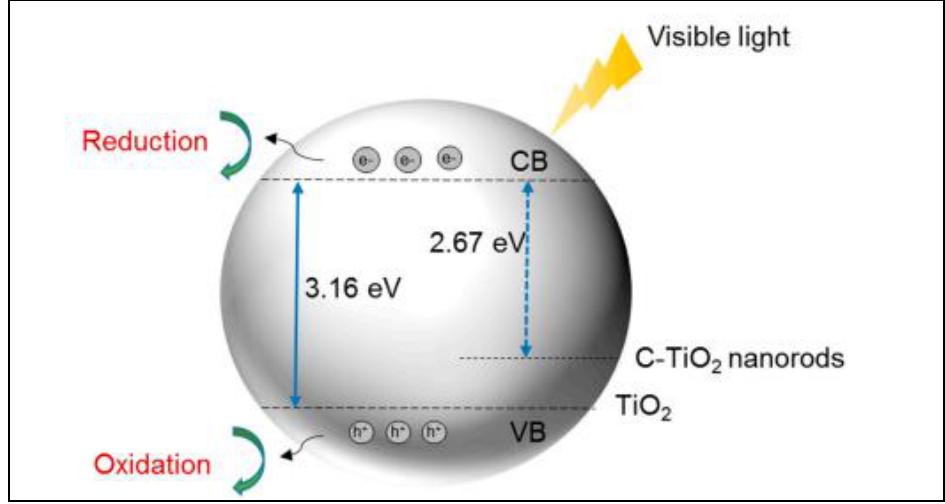
Figure 4. Photocatalysis mechanism of C-doped TiO 2 nanorods under visible light, adopted from [56].